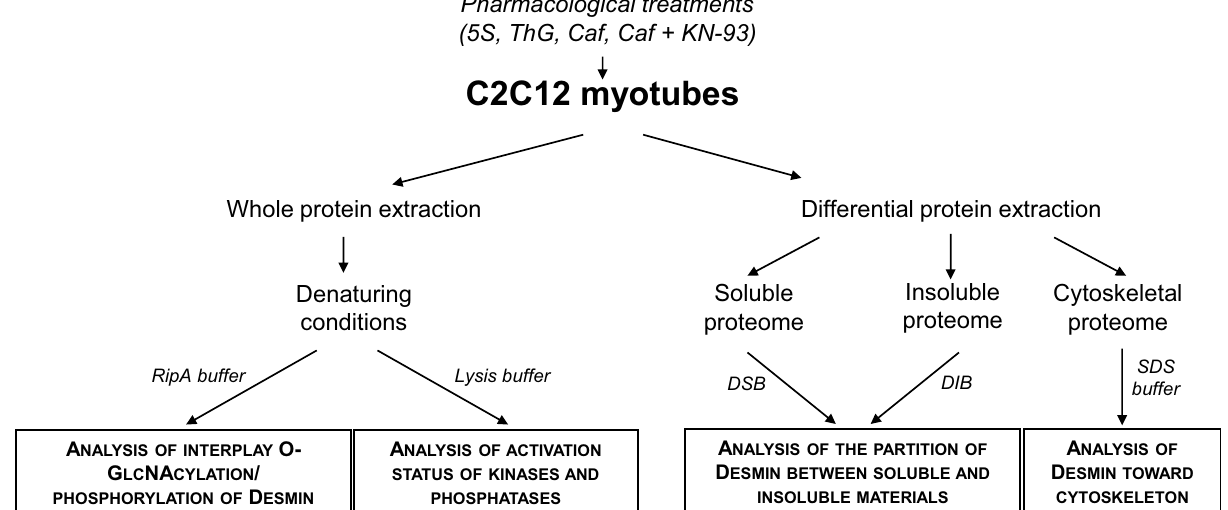
Figure 1. Recapitulative scheme of the different protein extraction protocols. This scheme indicated the protein subcellular fractions obtained, the corresponding buffers used and the downstream analyses for each